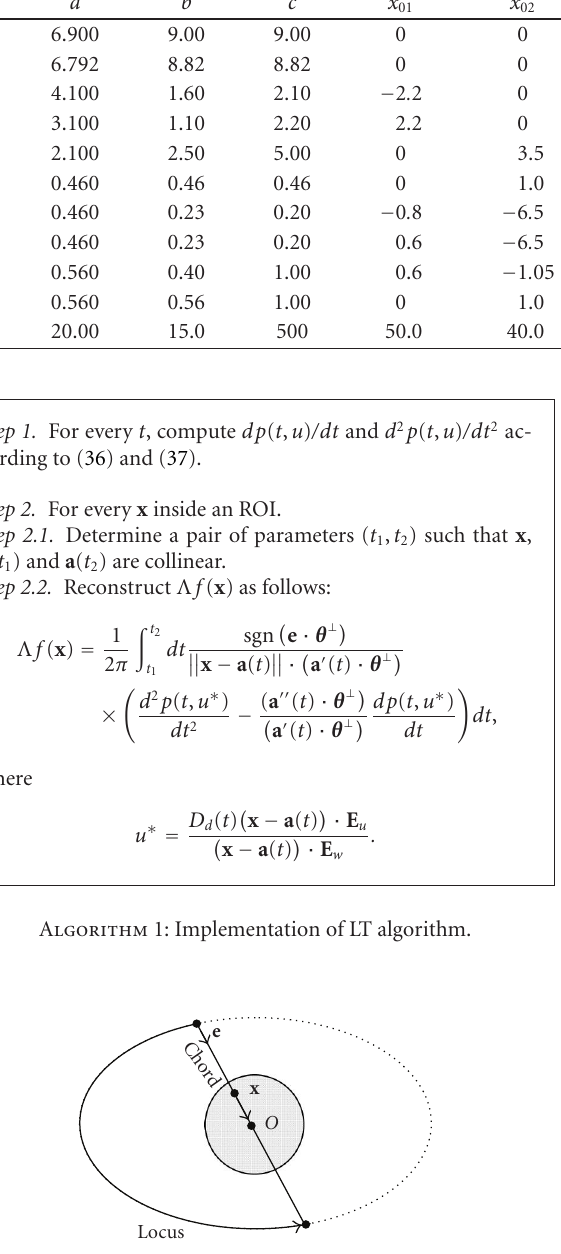
Figure 3: Selection of a chord through both x and the system origin.